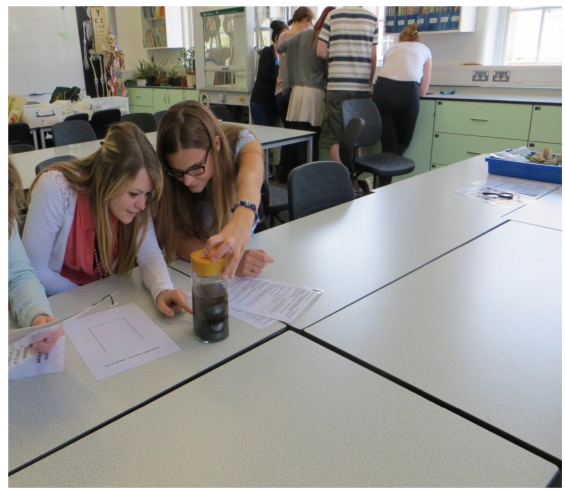
Figure 1. Trainee teachers investigating soil.